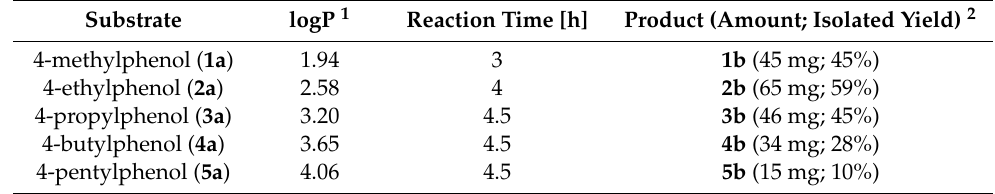
Table 1. Biocatalyzed transformations of 4-alkylphenols 1a – 5a into 4-alkylcatechols 1b – 5b. Substrate logP 1 Reaction Time [h] Product (Amount; Isolated Yield) 2 4-methylphenol ( 1a ) 1.94